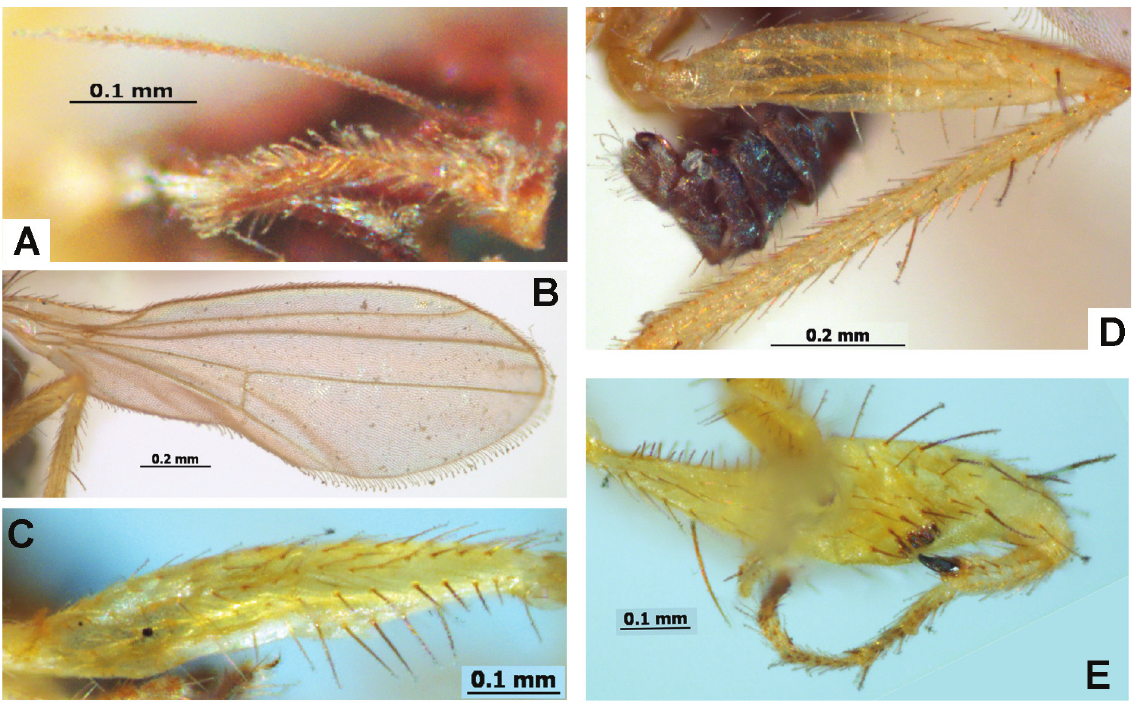
Fig. 2. Campsicnemus sanctaehelenae sp. nov., ♂ holotype. A . antenna. B . wing. C . mid femur. D . hind femur and tibia. E . mid tibia